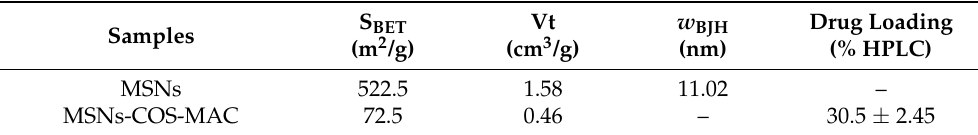
Figure 2. N 2 adsorption–desorption isotherms and the pore size distribution (inner) of MSNs and MSNs-COS-MAC. Table 1. Surface area, pore volume, pore diameter and degree of drug loading of MSNs and MSNs- COS-MAC.